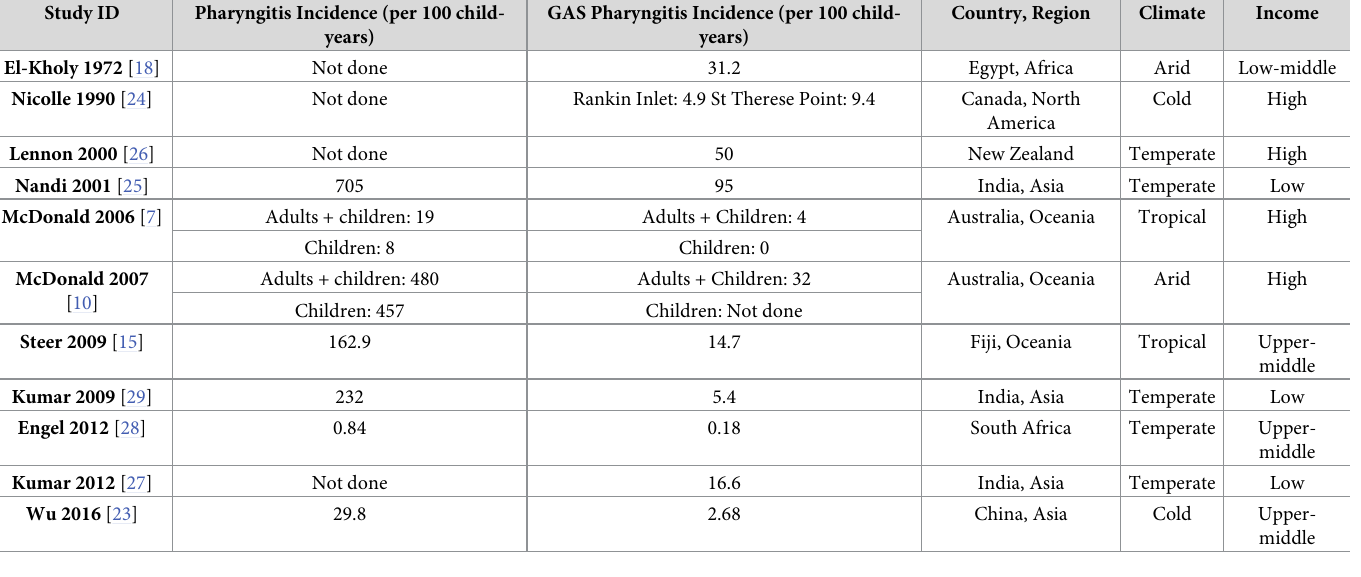
Table 3. Summary of incidence of sore throat and GAS pharyngitis in children at risk of acute rheumatic fever. Study